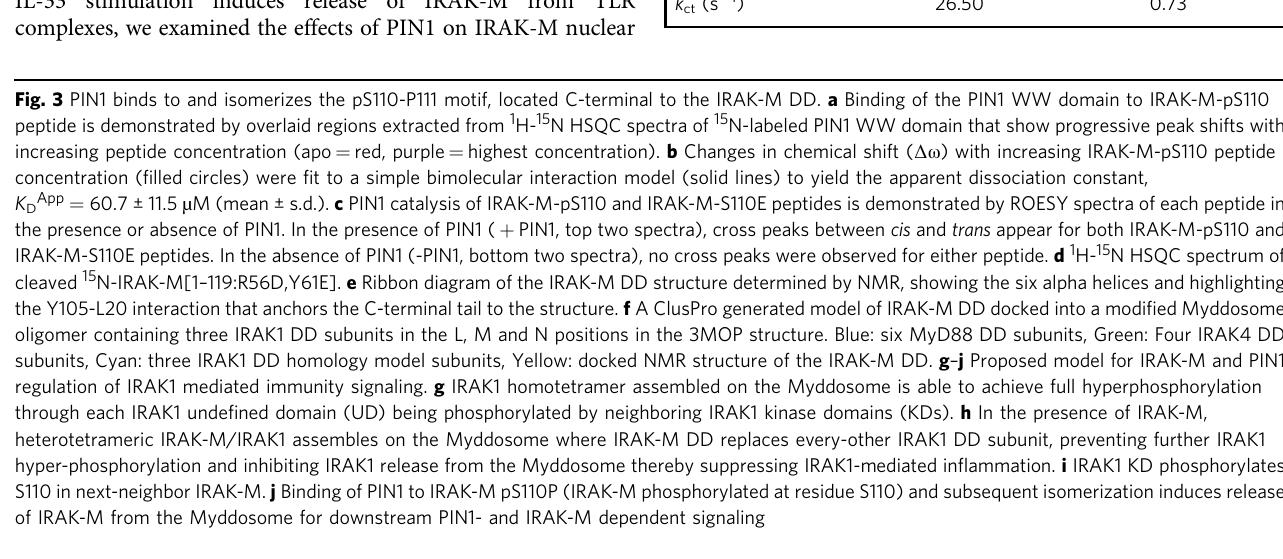
Table 1 Pin1-catalyzed isomerization rates of IRAK-M-pS110 and IRAK-M-S110E